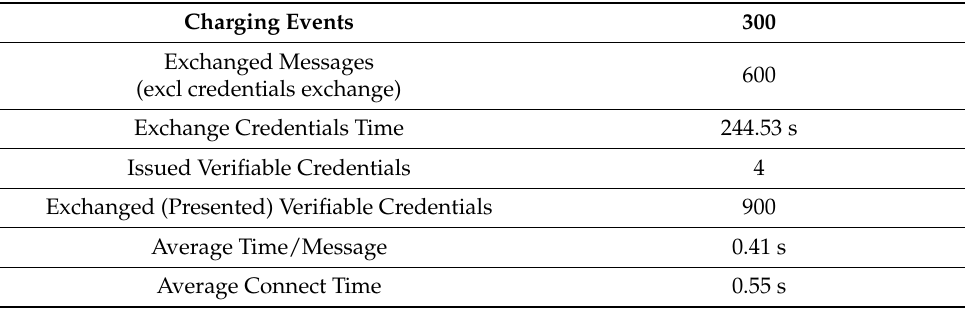
Table 1. Metrics for the simulation process.